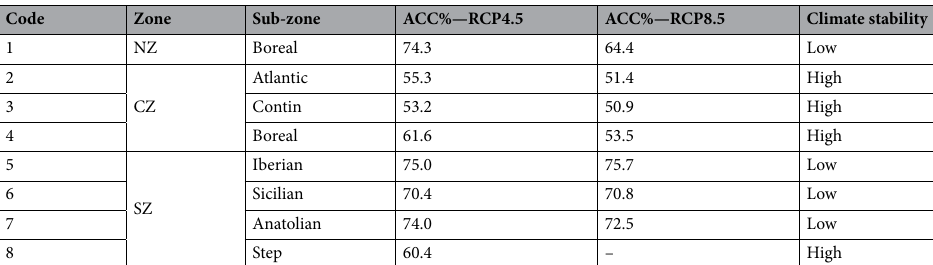
Table 2. Relative aggregate climate change (ACC%) in zones of low and high climatic stability as indicated by continental-scale assessment. The position of zones and sub-zones and the numerical codes correspond to Fig. 1. NZ Northern Zone, CZ Central Zone, SZ Southern